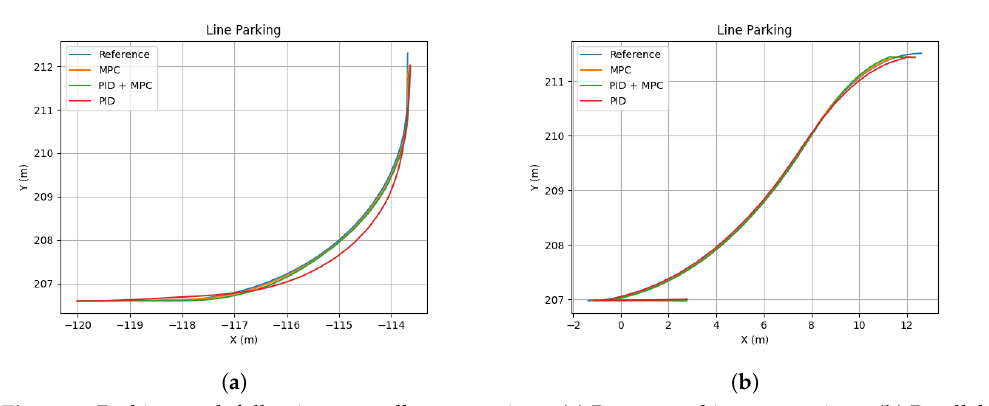
Figure 4. Parking track following controller comparison. ( a ) Battery parking comparison. ( b ) Parallel parking comparison. Table 1. Controller comparison of RMS error for parking maneuver. PID-s (Kp = 10; Ki = 0.1; Kd = 0).